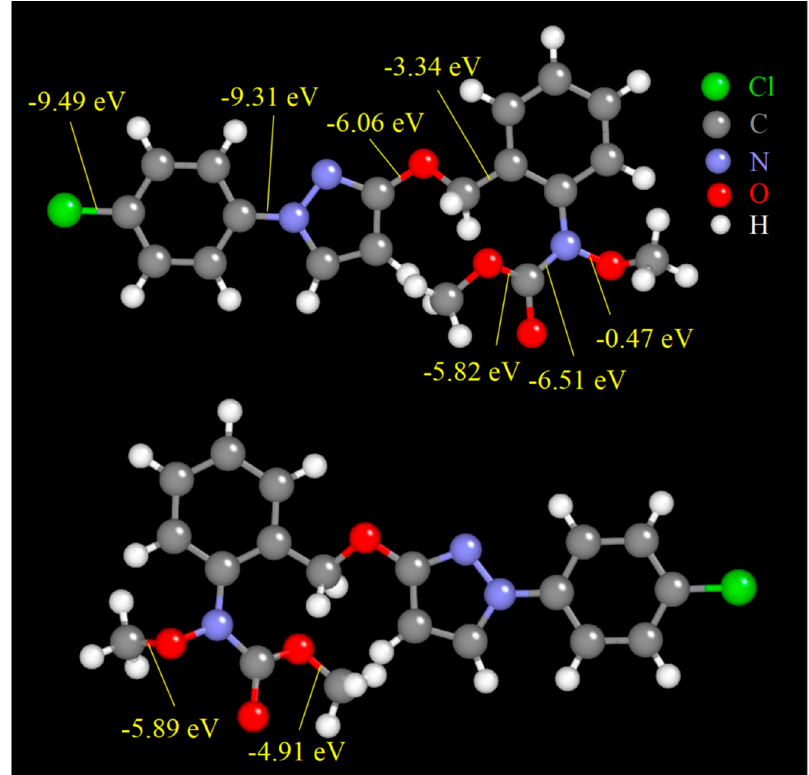
Figure 8. Optimized geometry and bonding of PYR.